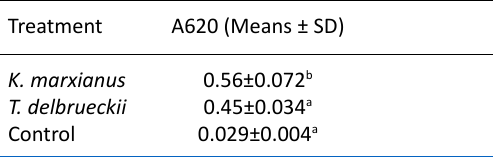
table 5. Biofilm formation on microtiter plates for K. marxianus and T. delbrueckii Treatment A620 (Means ± SD) K.